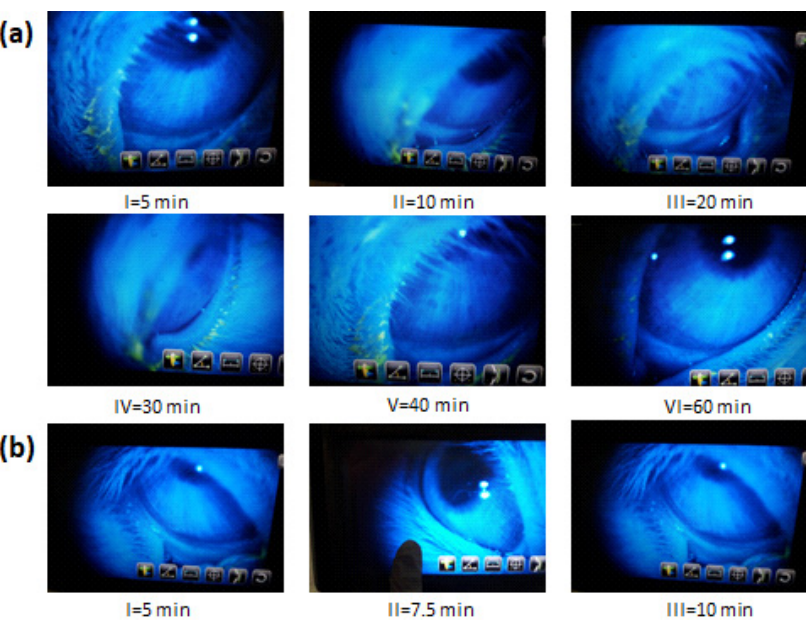
Figure 3. ( a ) In vivo fluorescein tracking study/elimination study. Before administration, fluorescein sodium salt was incorporated into the formulations to track the presence of eye drops. One drop of marketed solution eye drop of ciprofloxacin was administered in the lower conjunctival sac. An auto-refractometer visualized and showed that the elimination of the marketed eye drop was within 10 min [31]. ( b ) In vivo fluorescein tracking study/elimination study. Similarly, fluorescein sodium salt was incorporated into the formulations to track the presence of gel. One drop of in situ gel was administered in the lower conjunctival sac. An auto-refractometer visualized and showed that the elimination of the marketed eye drop was within 60 min